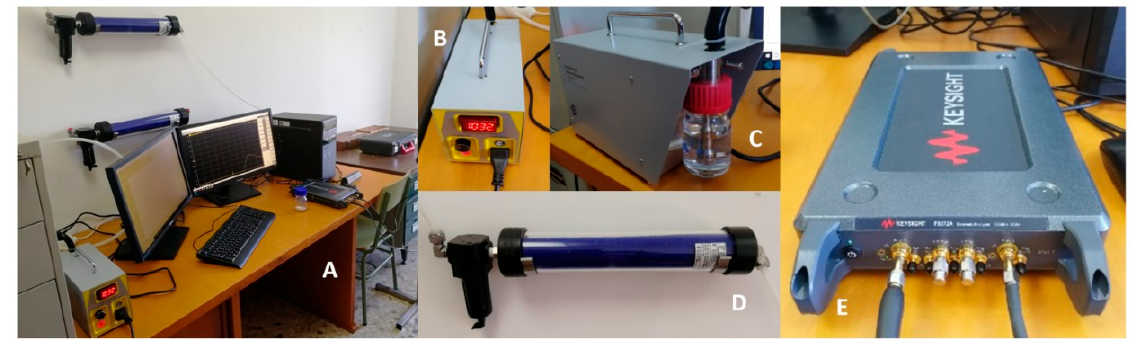
Figure 3. (A ) General view of the exposure set-up. ( B ) Polydisperse test aerosol generator TSI 3073. ( C ) Detail of the liquid solution to be introduced into the system for creating the suspension of particles. ( D ) Di ff usion dryer (TSI 3062) for drying the initial liquid solution introduced in ( C , E ) Vector Network Analyzer Keysight P9372A (300 kHz to 9 GHz).